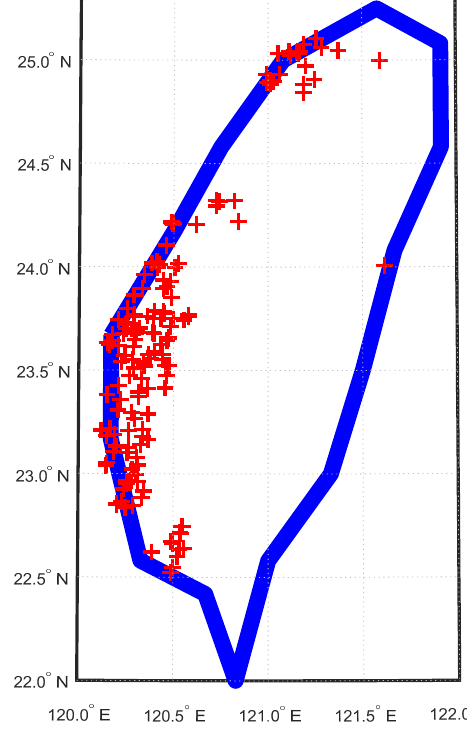
Figure 5. Geographical locations of 169 PV plants.